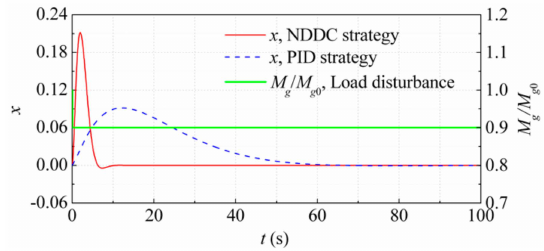
Figure 28. Comparison between the regulation qualities of the nonlinear disturbance decoupling control (NDDC) strategy and the PID strategy